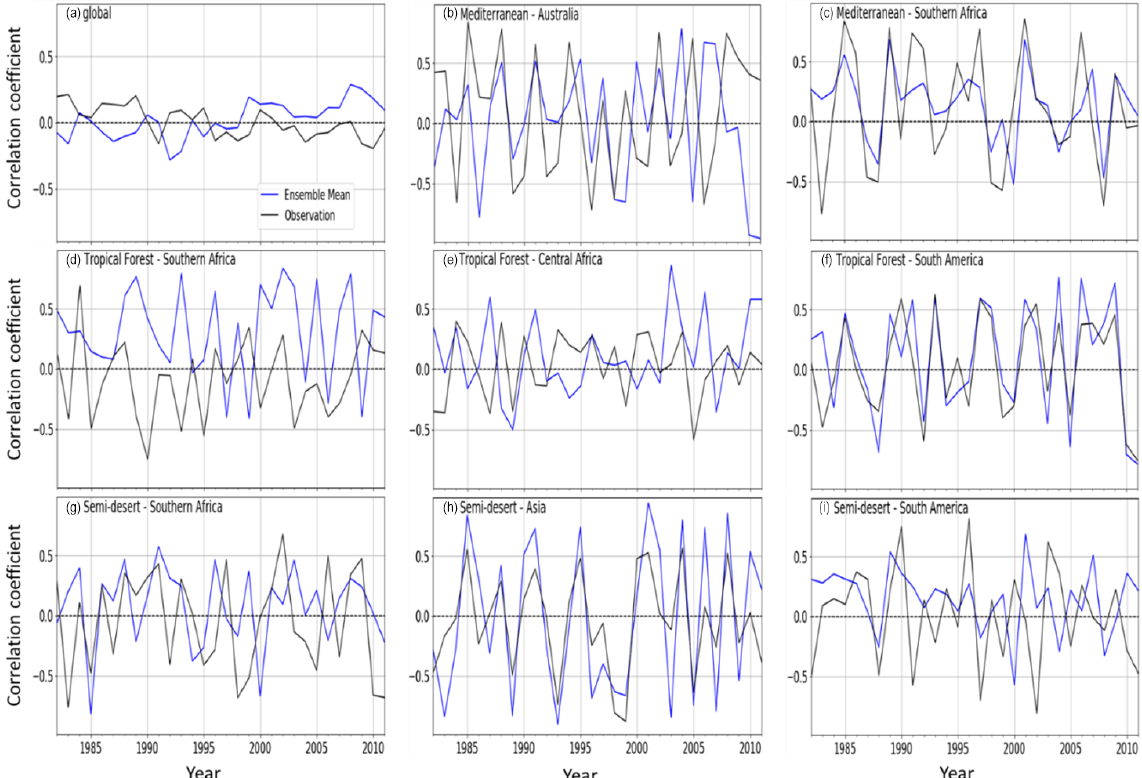
Figure 11. Correlations between SPEI (12-month timescale) and the ensemble mean of LAI from TRENDY (blue line) and GIMMS LAI (black line) for (a) global vegetation, (b) Mediterranean vegetation over Australia, (c) Mediterranean vegetation over southern Africa, (d) a tropical forest over southern Africa, (e) a tropical forest over central Africa, (f) a tropical forest over South America, (g) a semi-desert biome over southern Africa, (h) a semi-desert over Asia, and (i) a semi-desert over South America.